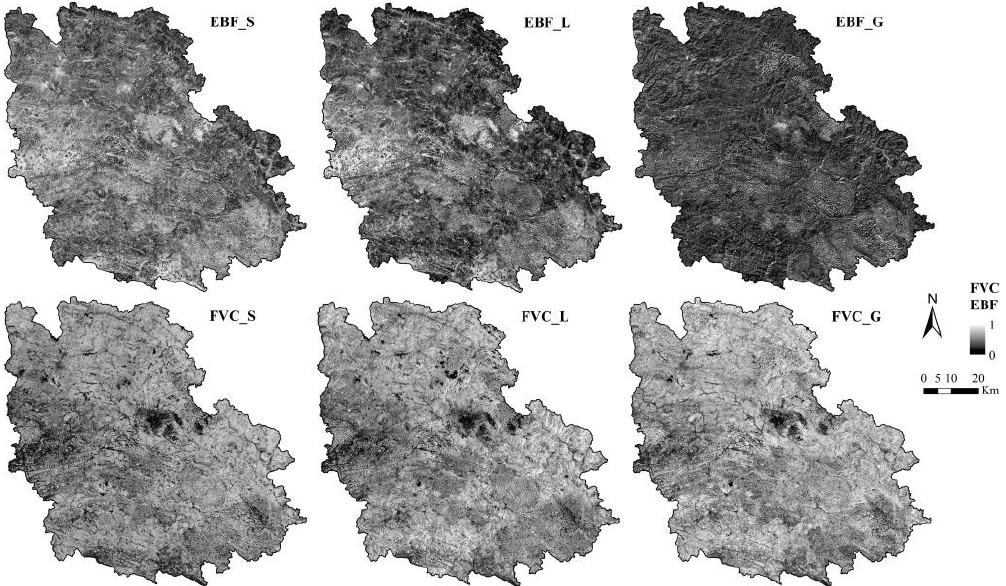
Figure 3. FVC and EBF information extracted from three image data (“S”, “L”, and “G” represent the remotely sensed indexes extracted from Sentinel-2B, Landsat-8, and Gaofen-6, respectively. For example, the “EBF_S” represents the EBF result generated by the Sentinel-2B image.).